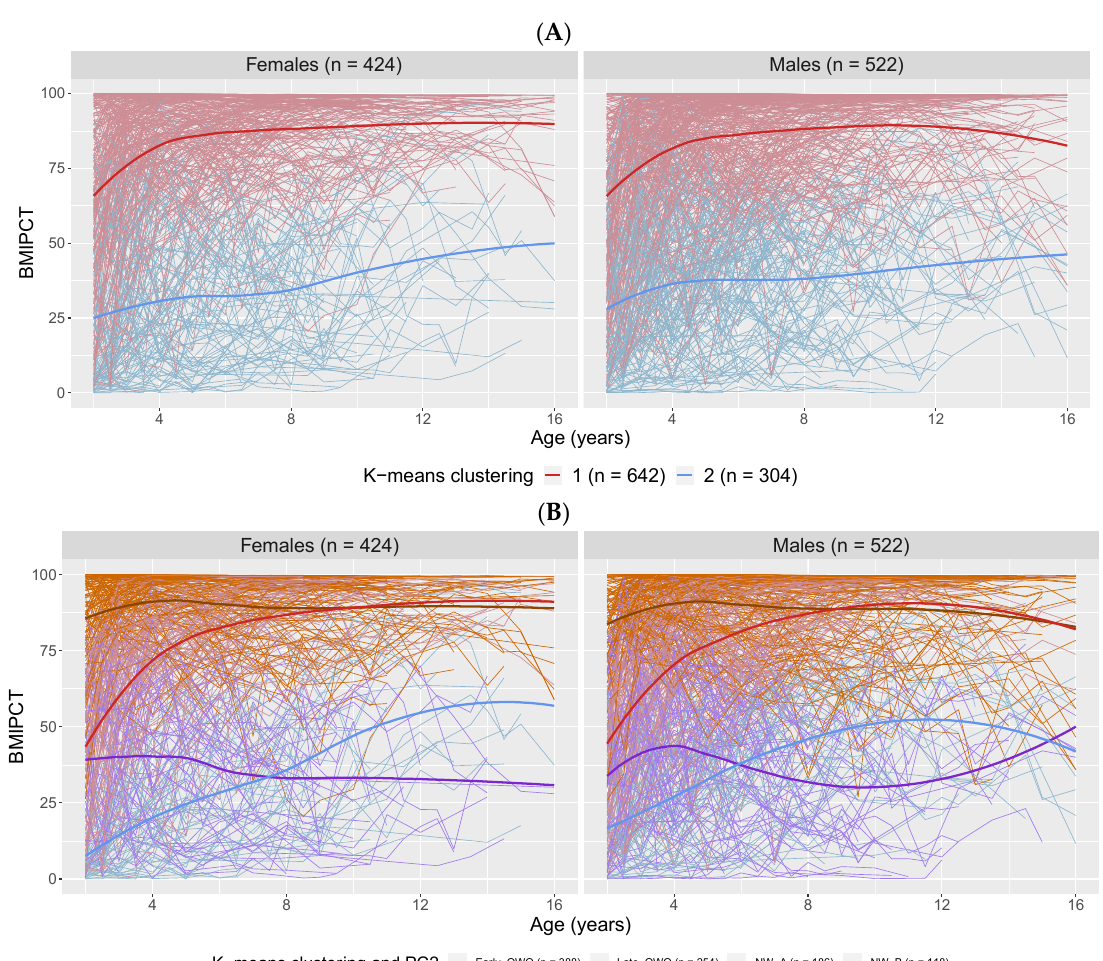
Figure 1. Longitudinal trajectory analysis: Plot of BMI trajectories for individual subjects (thin lines) colored by defined longitudinal BMI trajectories via k-means clustering into two groups ( A ) and via combining k-means clustering with PC2 information into 4 groups ( B ). Thick lines are the LOWESS smoothing curves for each group of subjects.